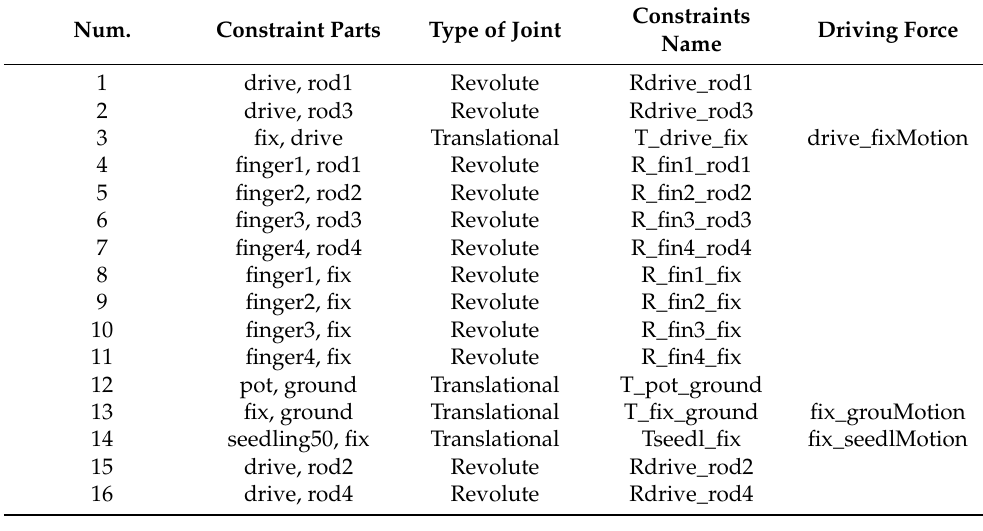
Table 2. Table of motion pairs for the model of end effector.